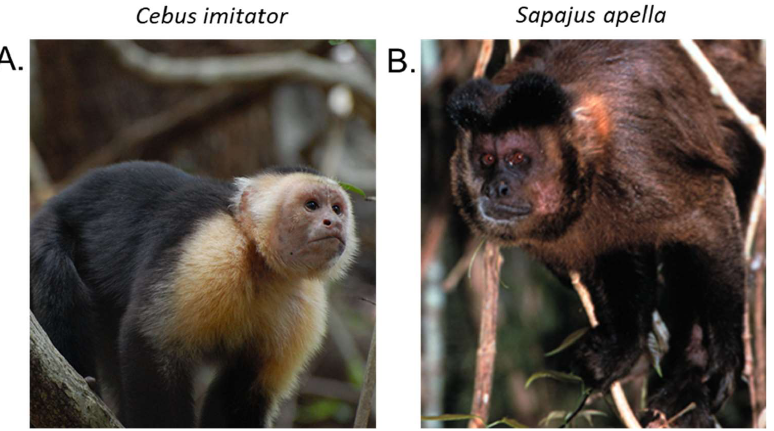
Figure 1. Photographs representative of untufted and tufted capuchins. ( A ) C. imitator , an untufted, adult male Panamanian white-faced capuchin. Photograph by Amanda Melin. ( B ) S. apella , a tufted, brown capuchin